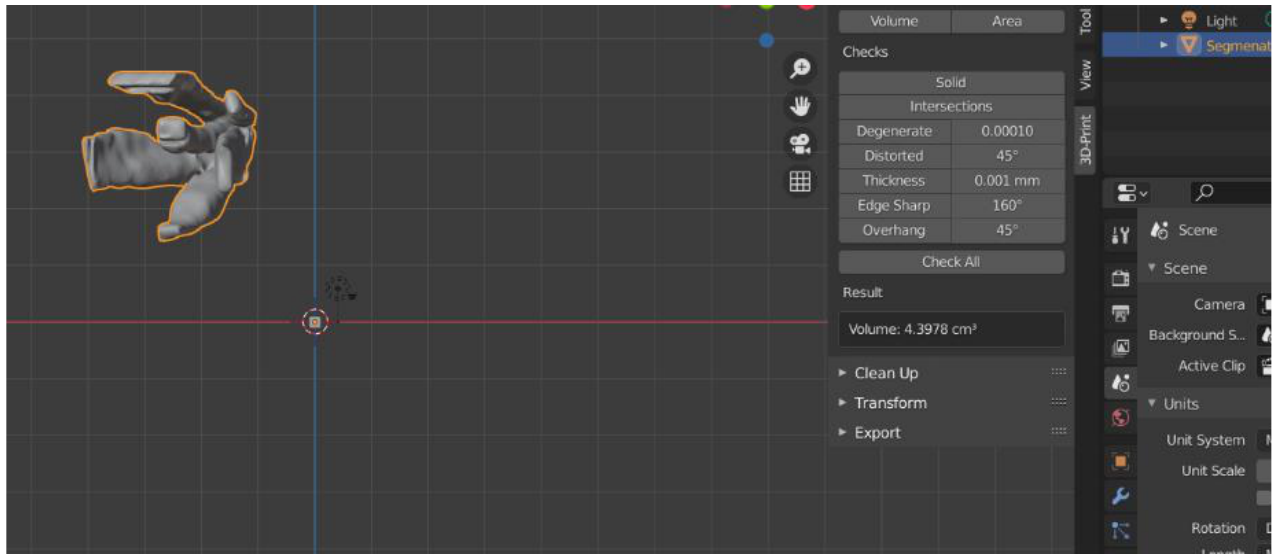
Figure 6. The volume of orbital muscles in cm 3 .